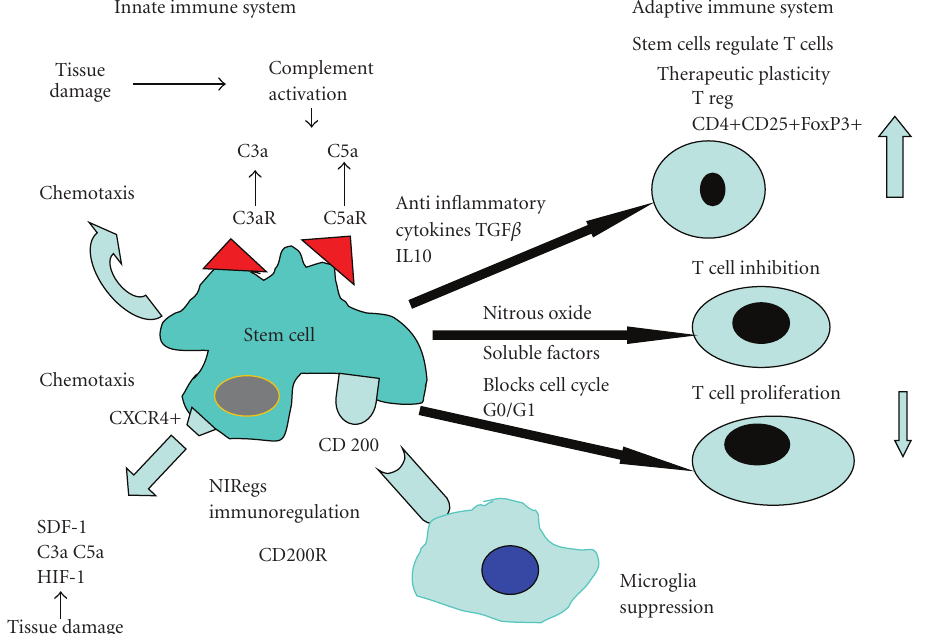
Figure 4: The figure shows the interactions between stem cells expressing the CXCR4 receptor and stroma-derived factor SDF-1 with the complement anaphylotoxin chemoattractants C3a and C5a; tissue damage contains the chemoattractant Hypoxia factor (HF-1), thrombin and complement anaphylotoxins (C3a and C5a). Stem cells express the (NIReg) immunoregulatory signal CD200 that inhibits microglial activation via the counter receptor CD200R. T cells are also inhibited through several di ff erent inhibitory pathways expressed by stem cells as well as stimulating Tregs; these interactions all reduce the severity of the inflammation and stimulate stem cell migration into areas of inflammation to assist with tissue repair; these e ff ects are termed “therapeutic